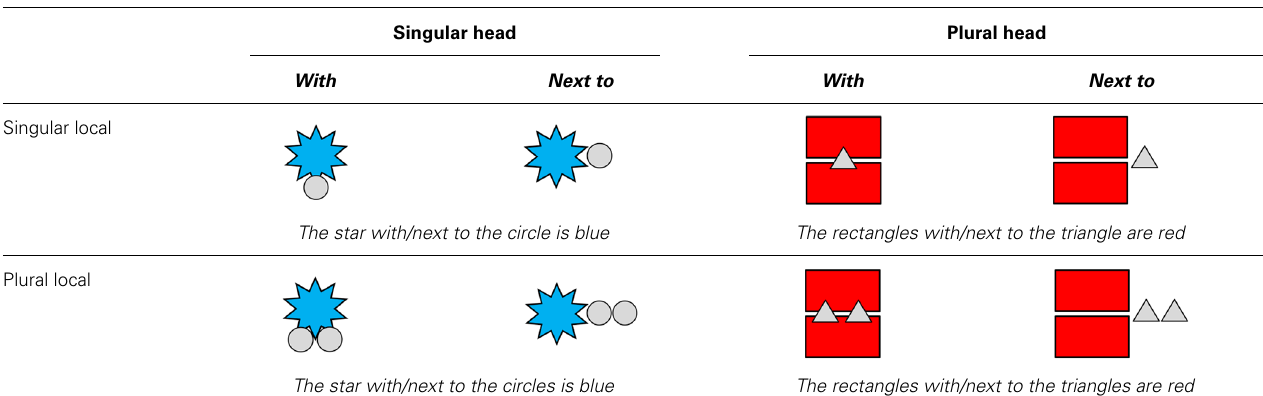
Table 1 |An example of pictures in eight conditions in Experiment